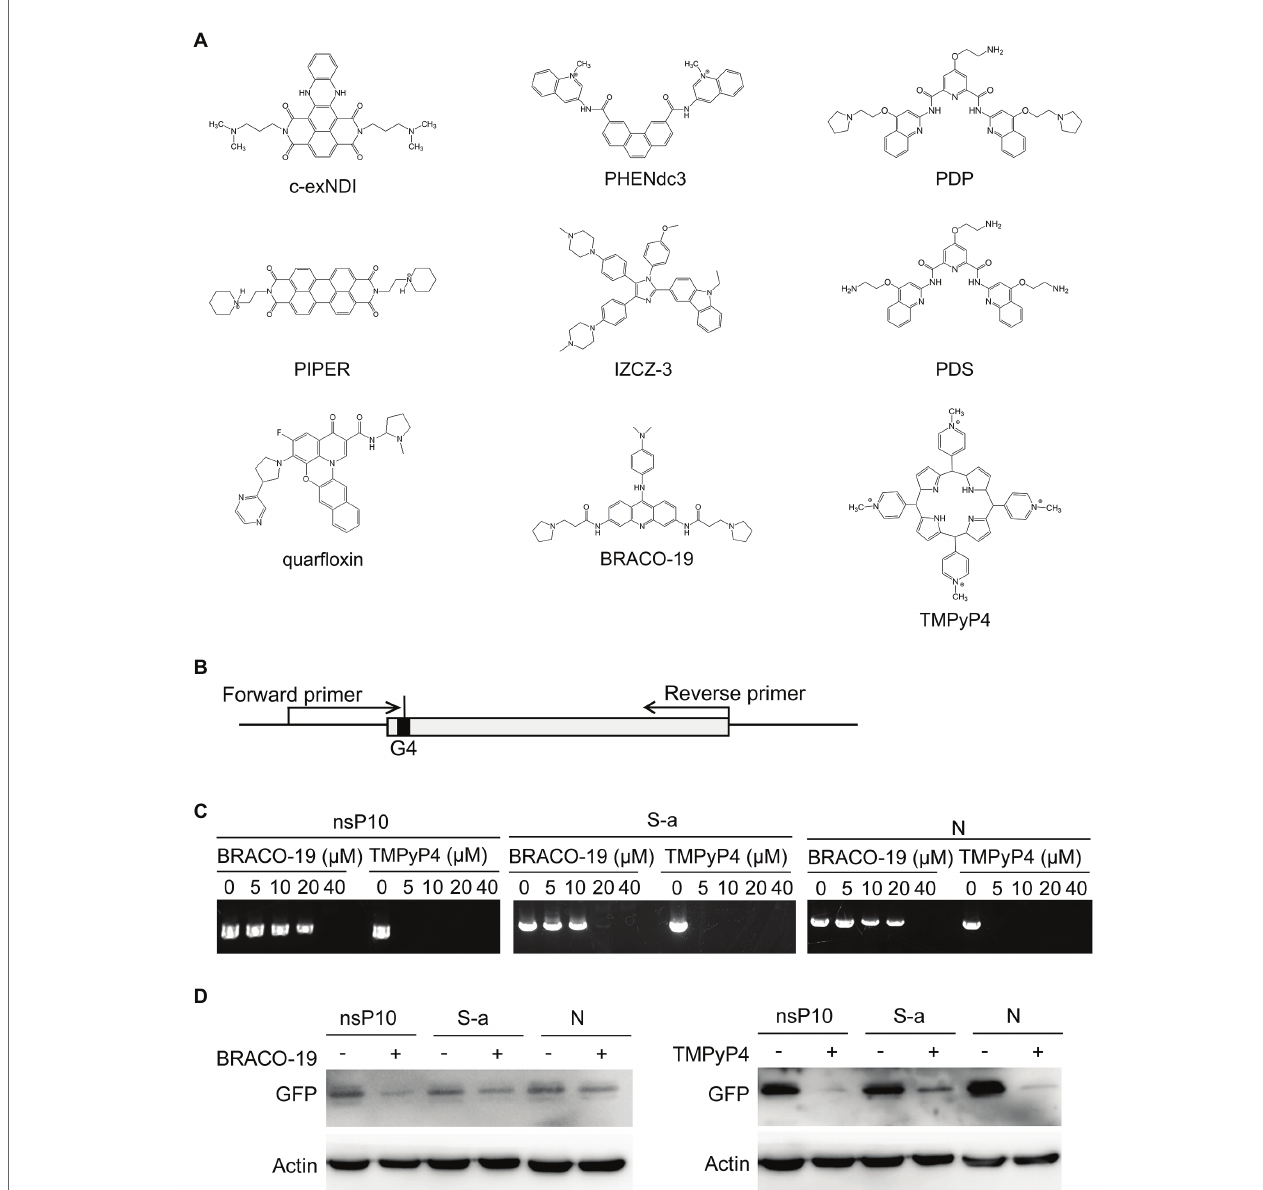
FIGURE 5 | G-quadruplex ligands BRACO-19 and TMPyP4 block G4-based gene expression. (A) G-quadruplex ligands with antiviral roles. (B) Schematic diagram of G-quadruplex containing plasmids construction and primer extension strategies. (C) PCR products of primer extension assay were observed by agarose electrophoresis. The concentrations of G-quadruplex ligands treatment were as indicated. (D) GFP expression level with or without treatment were detected through Western